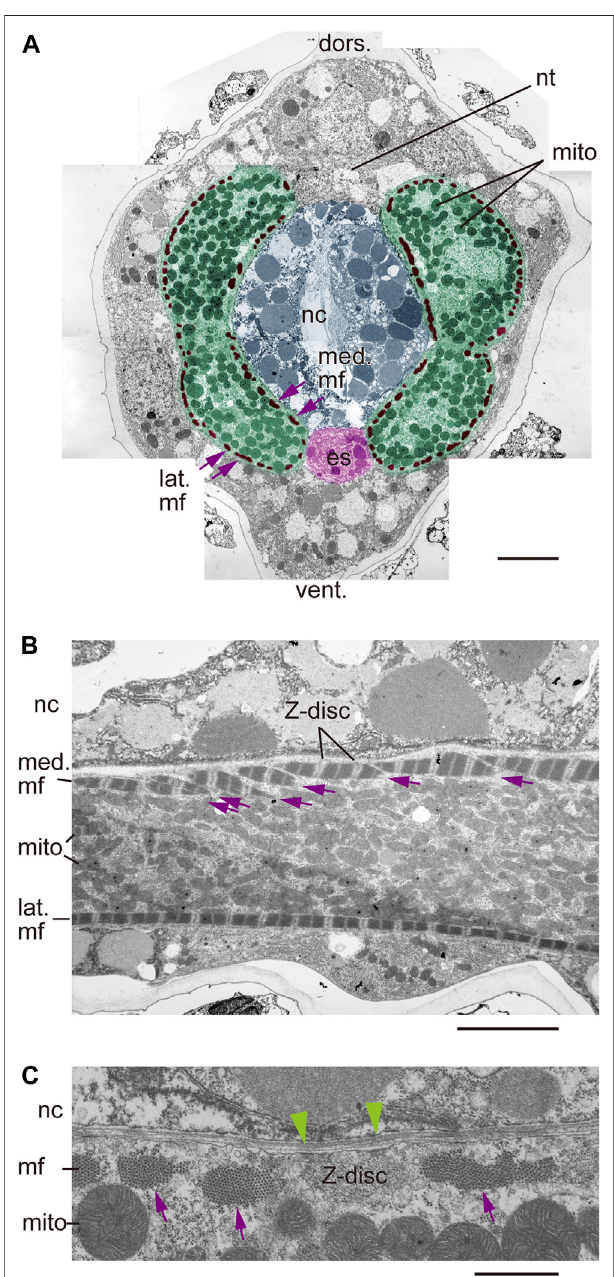
FIGURE 5 | Myo fi bril localization underneath the plasma membrane. (A) Transmissionelectron microscopy (TEM)of across-section ofthe Ciona larval tail.Pseudo-coloredstructuresaremusclecells(green),myo fi brils(mf,brown), notochord (nc, blue) and endodermal strand (es, red). nt, neural tube. mito,mitochondria.dors.,dorsal.vent.,ventral.med.,medial.lat.,lateral.Nine micrographs were stitched manually. Scale bar, 5 μ m. (B) TEM image of a semi-horizontal longitudinal section of the Ciona larval tail. Multiple myo fi brils on themedial plasmamembranefacingthenotochord (med.mf)areindicated by arrows. Note clearly visible Z-discs at sarcomere borders. Scalebar, 5 μ m. (C) Higher magni fi cation view of a Z-disc in the cross-section shown in (A) . Electron dense foci (green arrowheads) that may anchor myo fi brils to the plasmamembranewere detected. Multiple myo fi brils are indicated byarrows. Scale bar, 1 μ